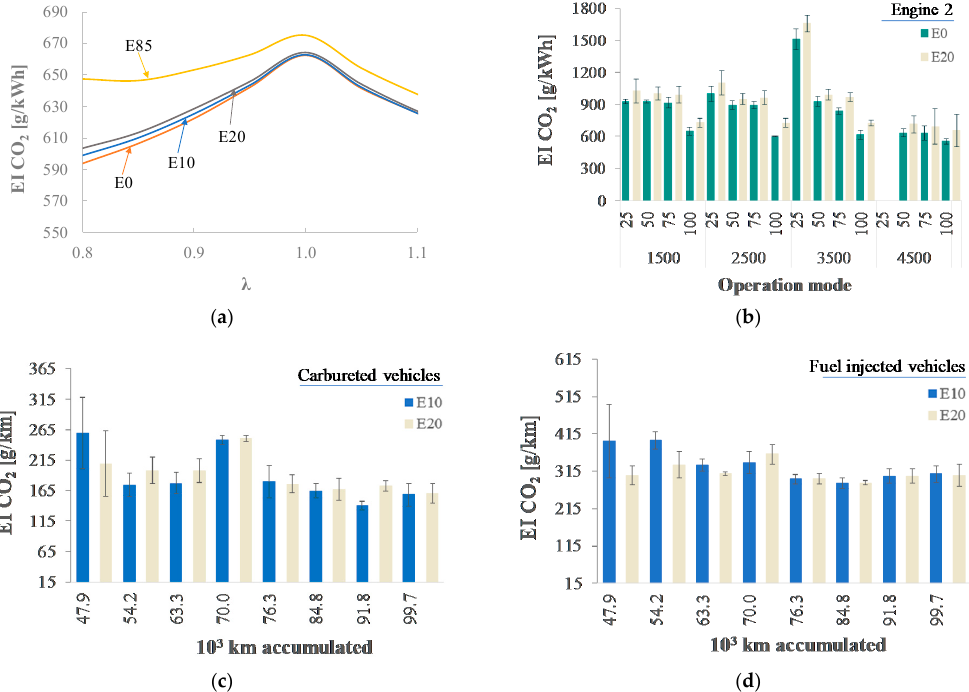
Figure 5. CO 2 emission indexes obtained through: ( a ) Analytical model; ( b ) Engine tests under steady- state conditions; ( c ) Carbureted and ( d ) Fuel-injected vehicles, following the new european driving cycle (NEDC) on chassis dynamometers, after every 10,000 km traveled .